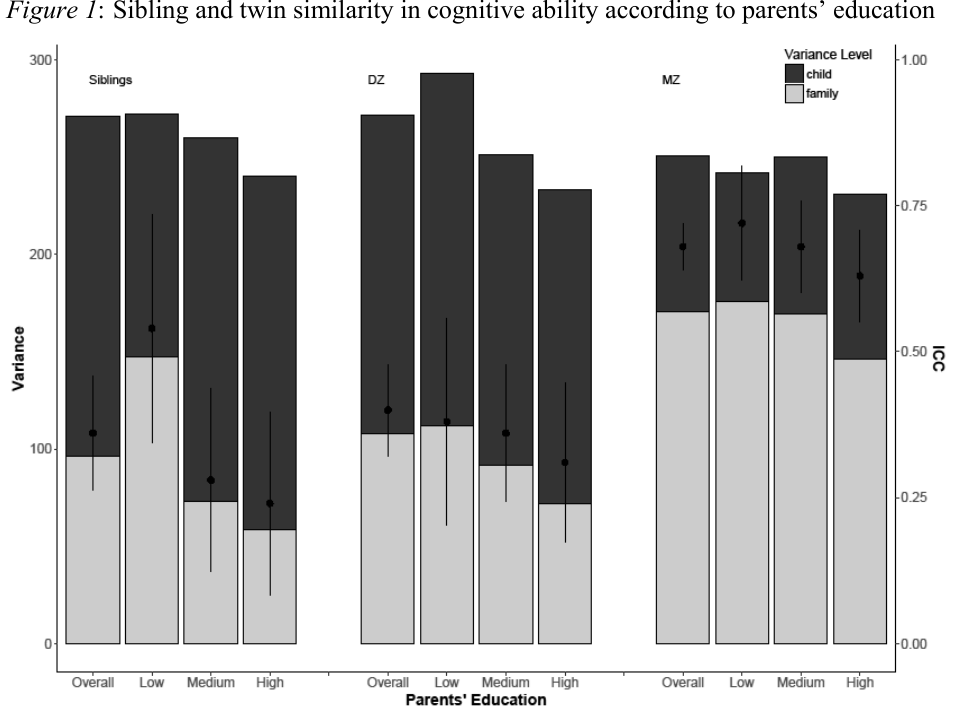
Figure 1 : Sibling and twin similarity in cognitive ability according to parents’